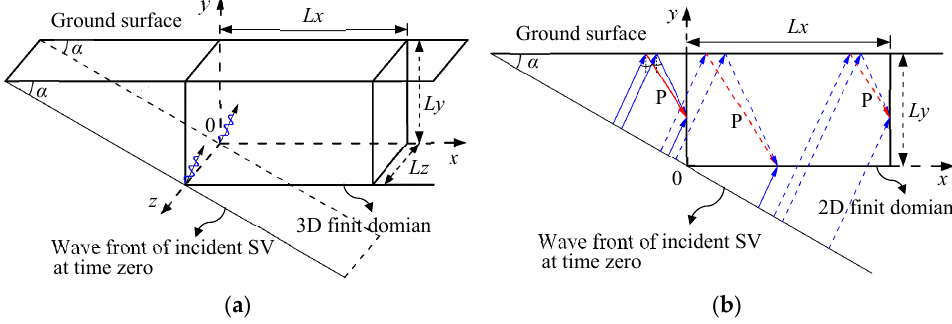
Figure 2. Schematic diagram of oblique incidence of plane SV wave condition: ( a ) 3D schematic diagram; ( b ) 2D schematic diagram.